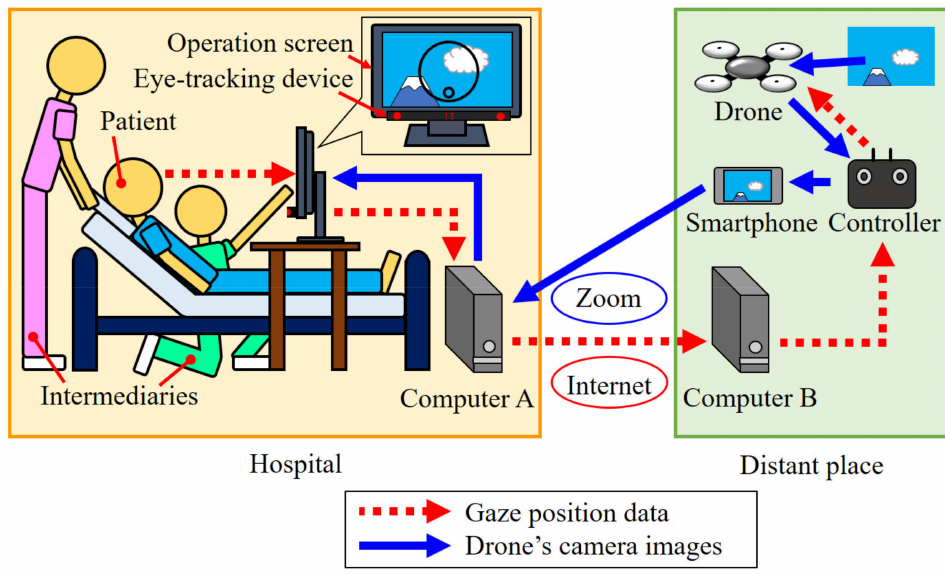
Figure 1. Remote-controlled drone